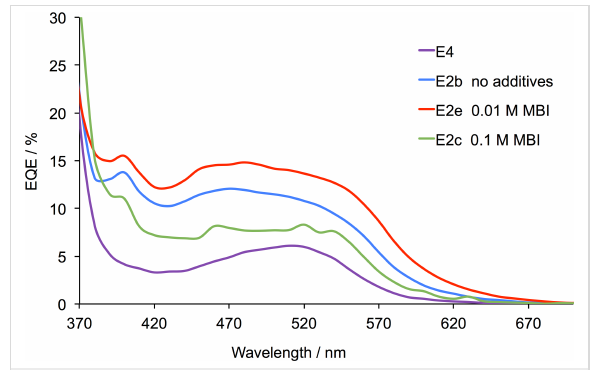
Figure 5: EQE spectra for the DSCs with dye 1 and electrolytes E4 (with EMIMPF as ionic liquid) and E2b, E2c, E2e (each with DMPII as ionic liquid) recorded on the day of sealing the DSCs. See also Figure S1, Supporting Information File 1.